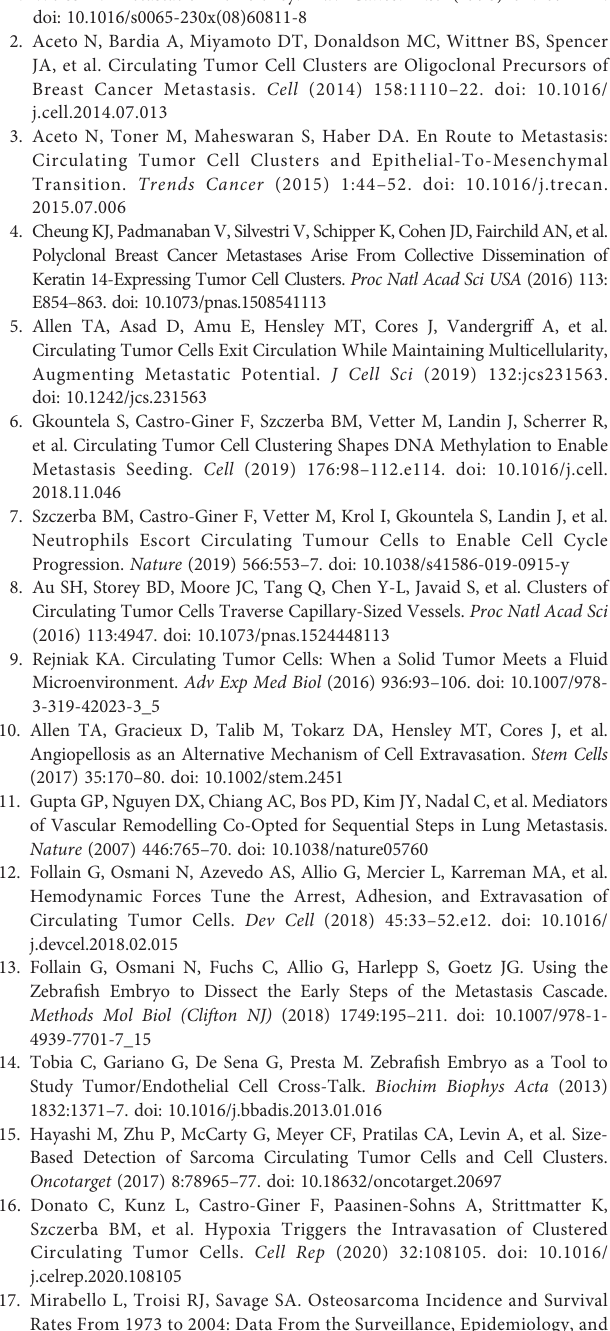
Supplementary Figure 3 | Extravasated circulating tumor cells downregulate the interferon gamma response pathway. (A) Gene regulatory networks for the interferon gamma response pathway in HMPOS and (B) D17. Blue denotes downregulation and red denotes upregulation (FDR<0.05). Nodes are scaled proportionally to log2FC, with larger nodes depicting greater log2FC between extravasated and parental cell lines. (C) Scatter plot of sum rank of network